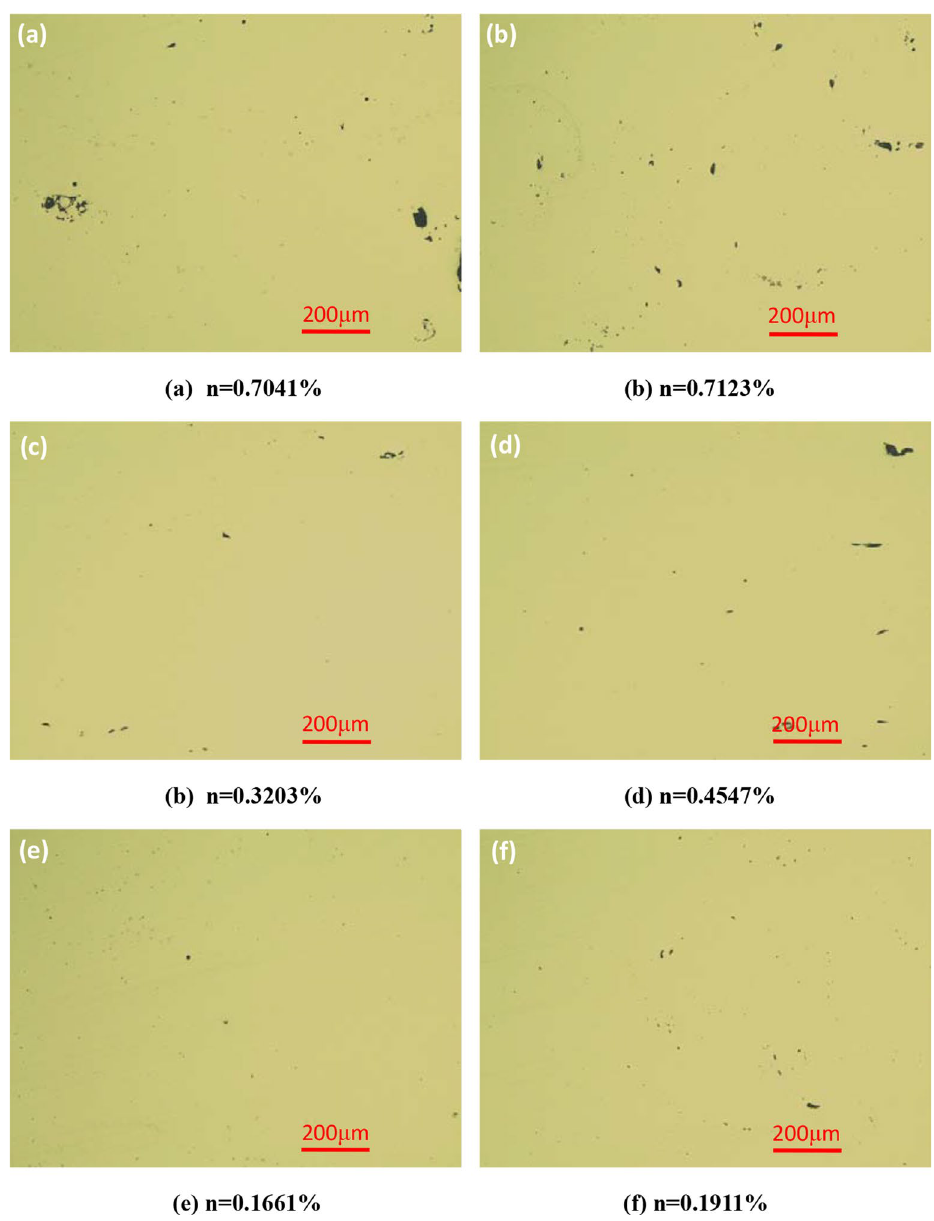
Figure 10. Microstructure of samples under different scanning strategies: ( a , b ) Island scanning; ( c , d ) helix scanning; ( e , f ) slope subarea scanning; ( a , c , e ) HD; ( b , d , f )